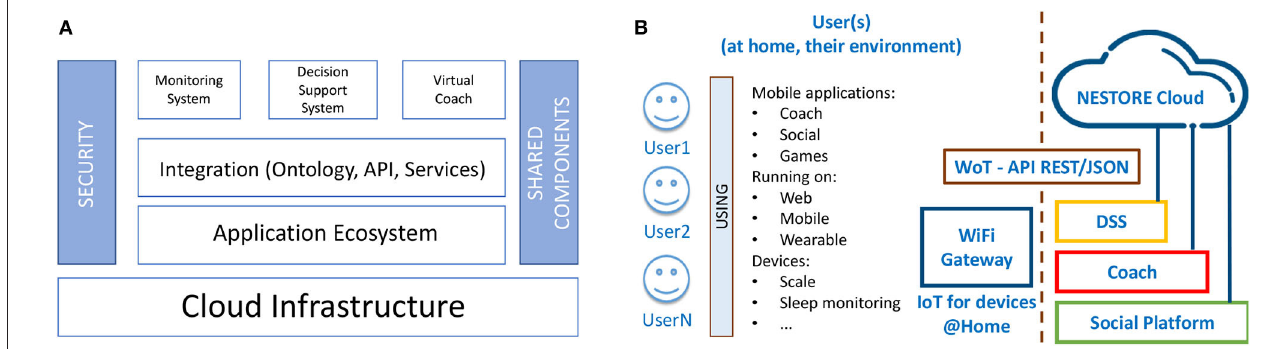
FIGURE 3 | Overall view of the NESTORE integrated IoT architecture: (A) shared functional modules and (B) used technological